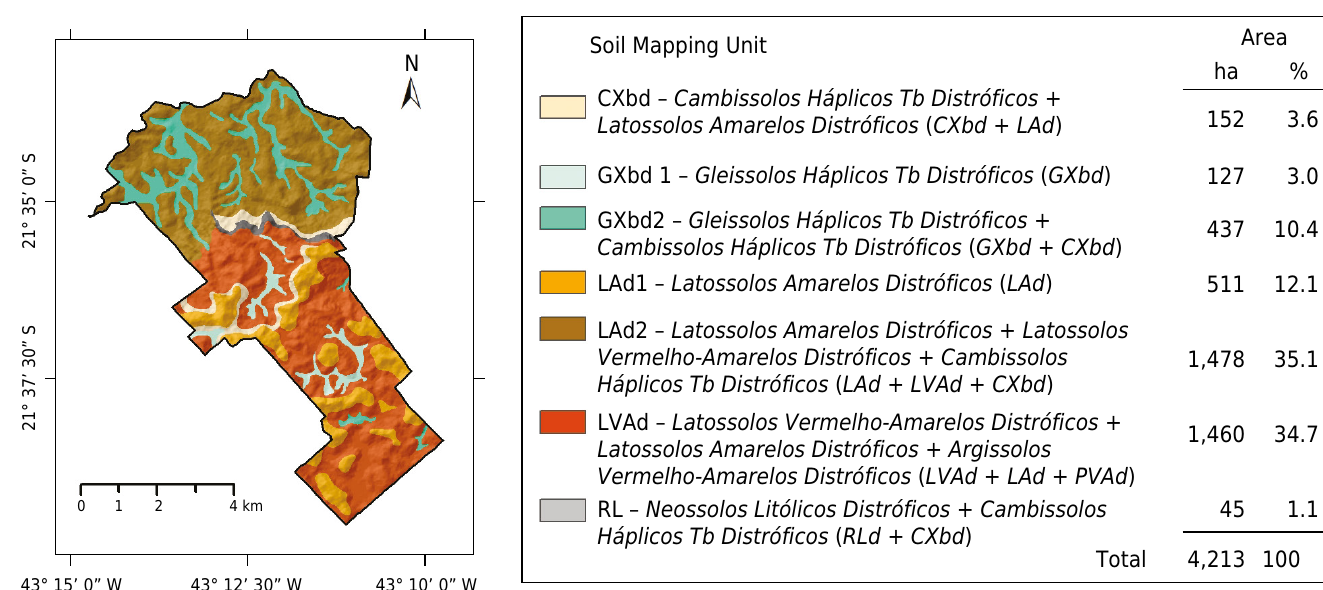
Figure 2. Conventional soil map showing the distribution of soil mapping units (MUs) and their areas of occurrence in the Dênis Gonçalves Settlement, in the Zona da Mata region, Minas Gerais,